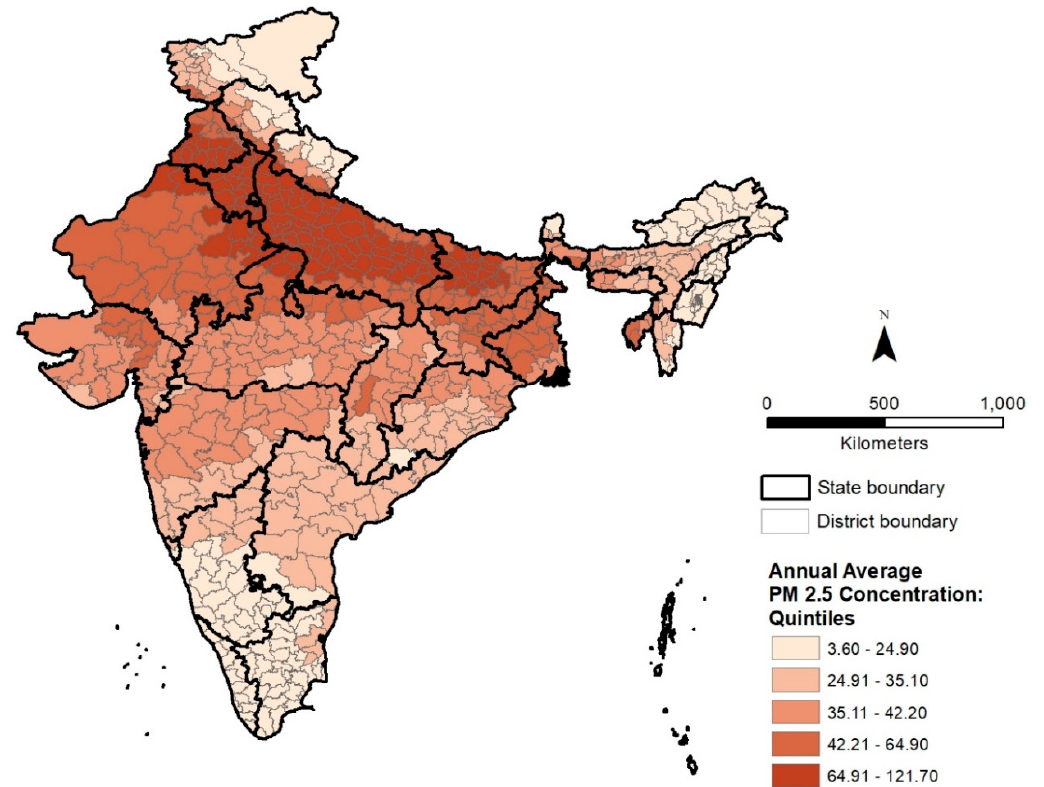
Figure 2. Distribution of 2010 surface annual average PM 2.5 concentrations ( μ g/m 3 ) by district in India.